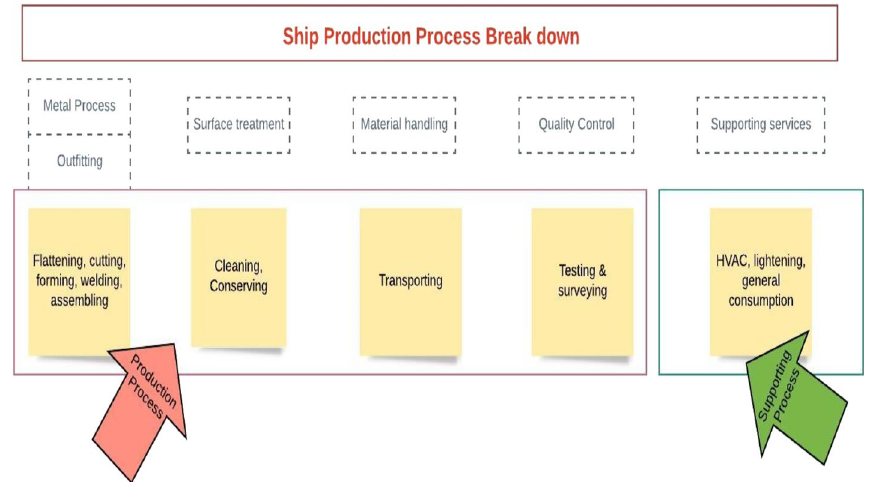
Fig. 4 The typical ship production process in the shipyard